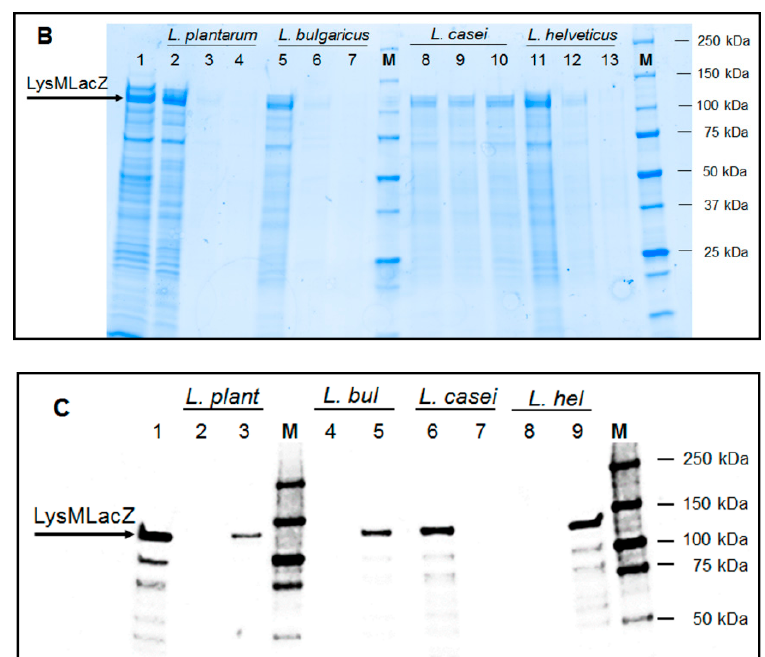
Figure 3. SDS-PAGE analysis ( A , B ) and Western blot analysis ( C ) of immobilization of recombinant enzymes. LacLMLreu encoded by two overlapping genes lacLM and LacZLbul encoded by lacZ gene are the β -galactosidases from L. reuteri and L. delbrueckii subsp. bulgaricus DSM 20081, respectively. The arrows indicate the subunits of the recombinant β -galactosidases. M denotes the Precision protein ladder (Biorad, CA, USA). ( A ) Cell-free crude extracts of E. coli HST08 harboring pBAD3014LacLMLreu (containing LysM-LacLMLreu) at 18 h of induction (lane1); flow through during immobilization (lane 2); surface anchored-LysM-LacLMLreu in L. plantarum WCFS1 (lane 3) and washing fractions (lanes 4, 5); non-displaying L. plantarum WCFS1 cells, negative control (lane 6). ( B ) Cell-free crude extracts of E. coli HST08 harboring pBAD3014LacZLbul (containing LysM-LacZLbul) at 18 h of induction (lane1); flow through during immobilization on the cell surface of L. plantarum WCFS1 (lane 2) and washing fractions (lanes 3, 4); flow through during immobilization on the cell surface of L. delbrueckii subsp. bulgaricus DSM 20081 (lane 5) and washing fractions (lanes 6, 7); flow through during immobilization on cell surface of L. casei (lane 8) and washing fractions (lanes 9, 10); flow through during immobilization on cell surface of L. helveticus DSM 20075 (lane 11) and washing fractions (lanes 12, 13). ( C ) Cell-free crude extracts of E. coli HST08 harboring pBAD3014LacZLbul (containing LysM-LacZLbul) at 18 h of induction (lane 1); non-displaying L. plantarum WCFS1 cells (lane 2) and surface anchored-LysM-LacZLbul in L. plantarum WCFS1 (lane 3); non-displaying L. delbrueckii subsp. bulgaricus DSM 20081 cells (lane 4) and surface anchored-LysM-LacZLbul in L. delbrueckii subsp. bulgaricus DSM 20081 (lane 5); surface anchored-LysM-LacZLbul in L. casei (lane 6) and non-displaying L. casei cells (lane 7); non-displaying L. helveticus DSM 20075 cells (lane 8) and surface anchored-LysM-LacZLbul in L. helveticus DSM 20075 (lane 9).